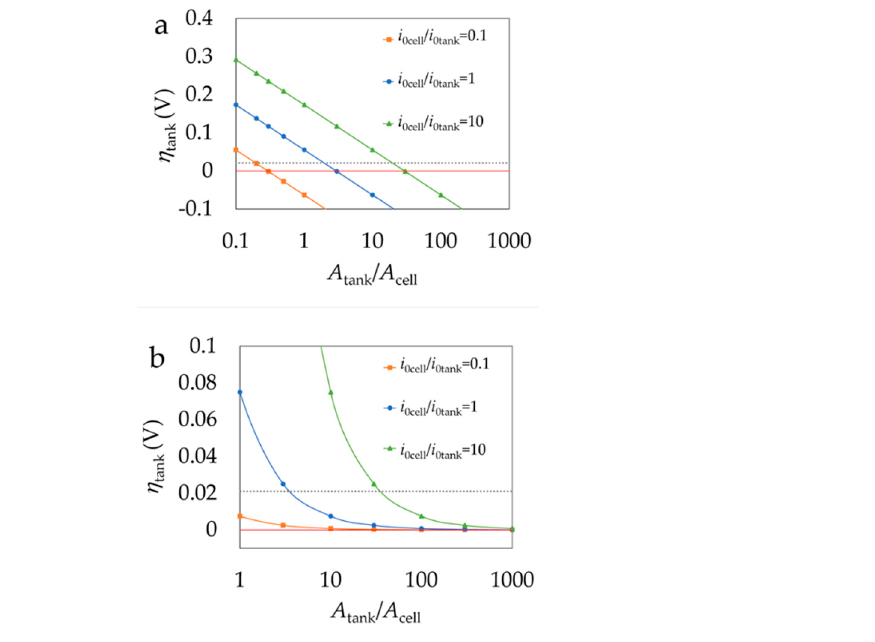
Figure 10. Overpotential of reaction in the tank ( η tank )’s dependence on the ratio of active area of solid beads in the tank ( A tank ) and active area of electrode ( A cell ) for three cases with different exchange current ratios. The overpotential in the electrode (| η cell |) is 0.055 V. ( a ) Equation (20). ( b ) Equation (22). Dashed lines mark the 21 mV of overpotential available from the 10% SoC change.